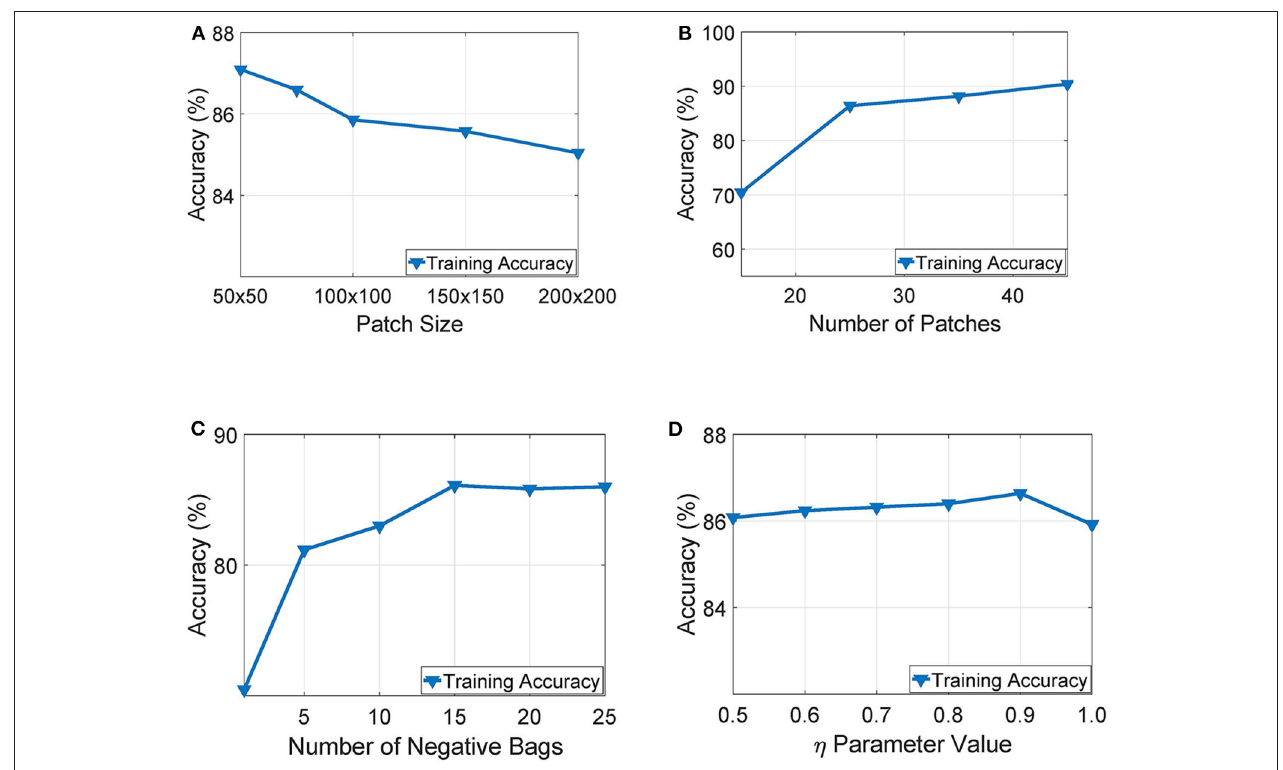
FIGURE 6 | Parameter exploration for, (A) patch size, (B) number of patches, (C) number of negative bags and, (D) η parameter.